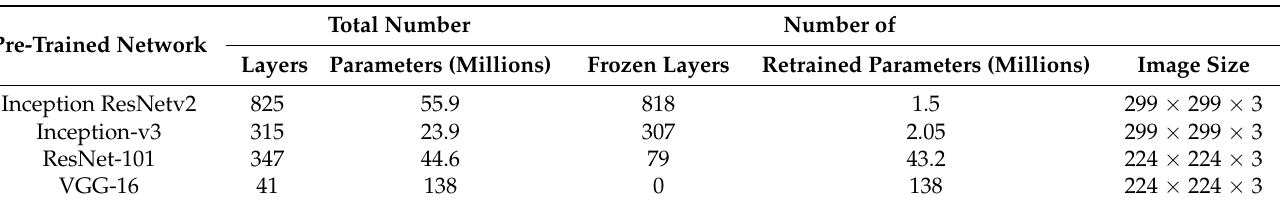
Table 2. Number of retrained cross-validation results for Sheffield and Piracicaba